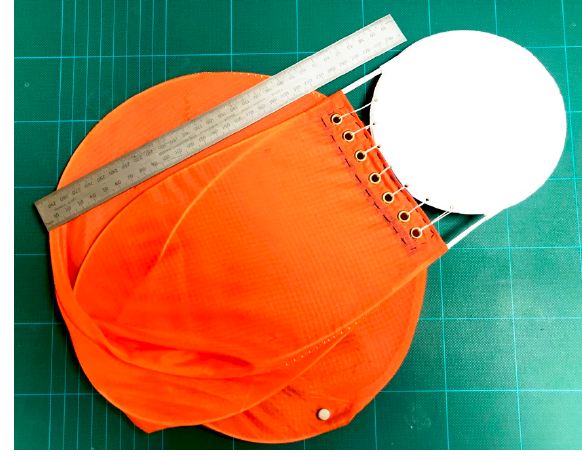
Figure 10. Photograph of TA2 in stowed configuration.